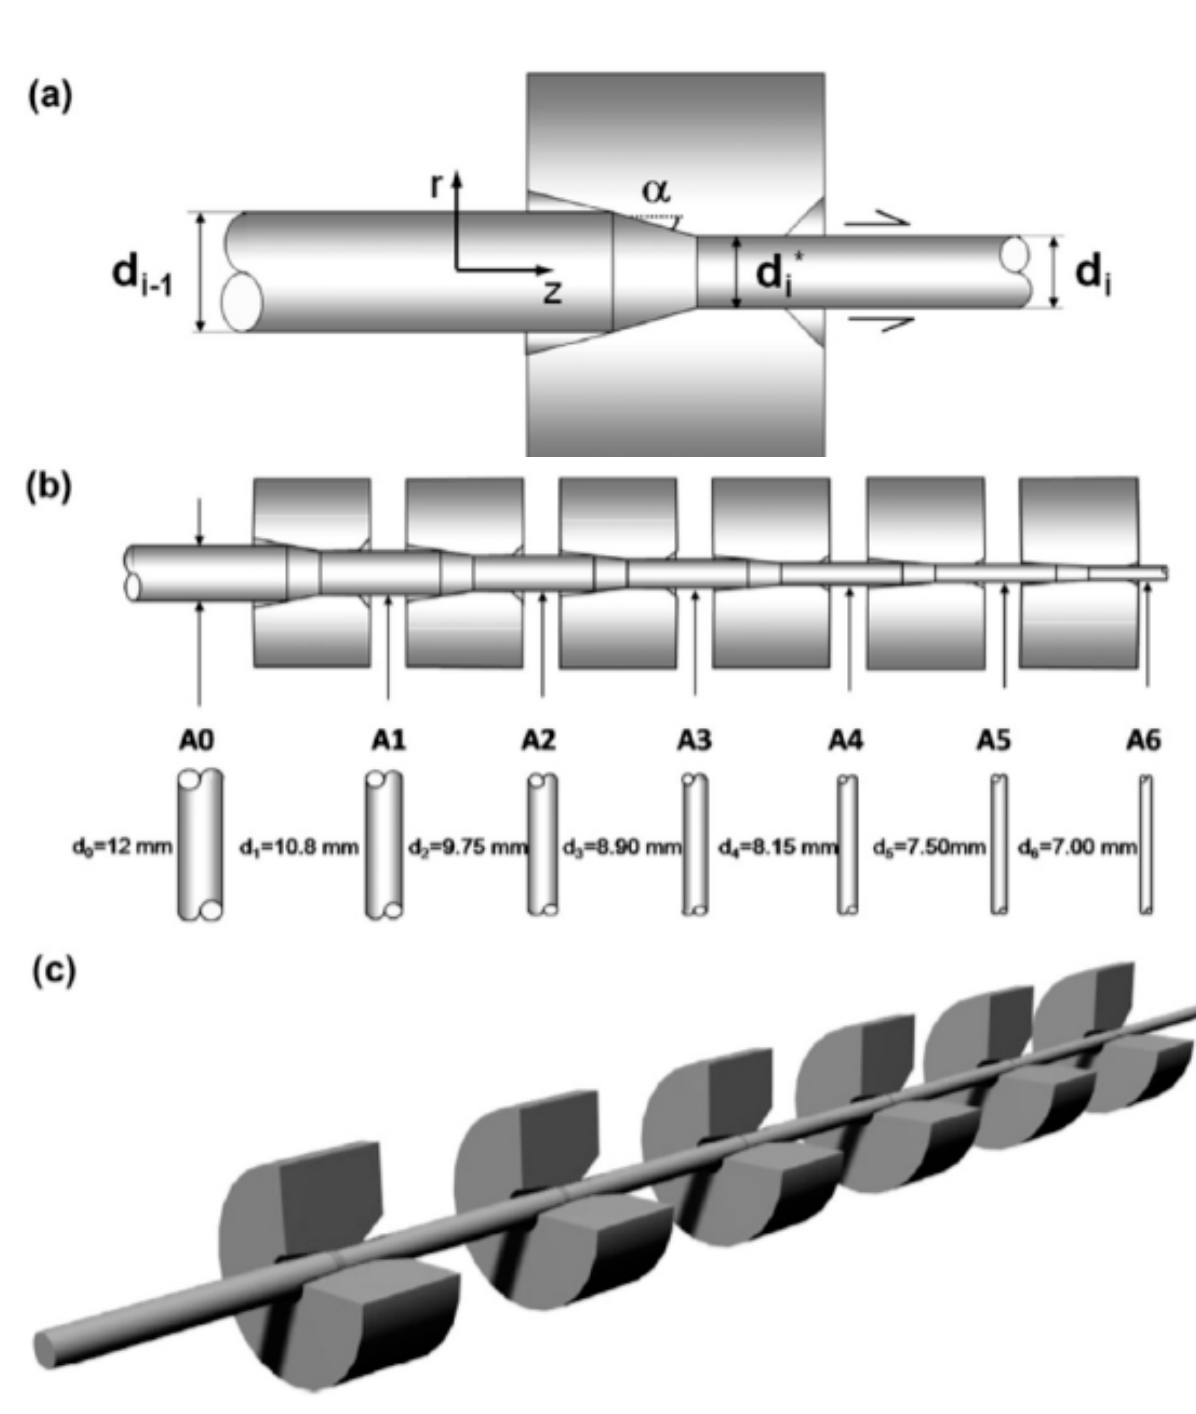
Figure 28. Diagram of the cold drawing process: ( a ) single-pass steel drawing through the die (one-pass cold drawing), ( b ) 6-pass progressive cold drawing, and ( c ) whole manufacturing chain [63].